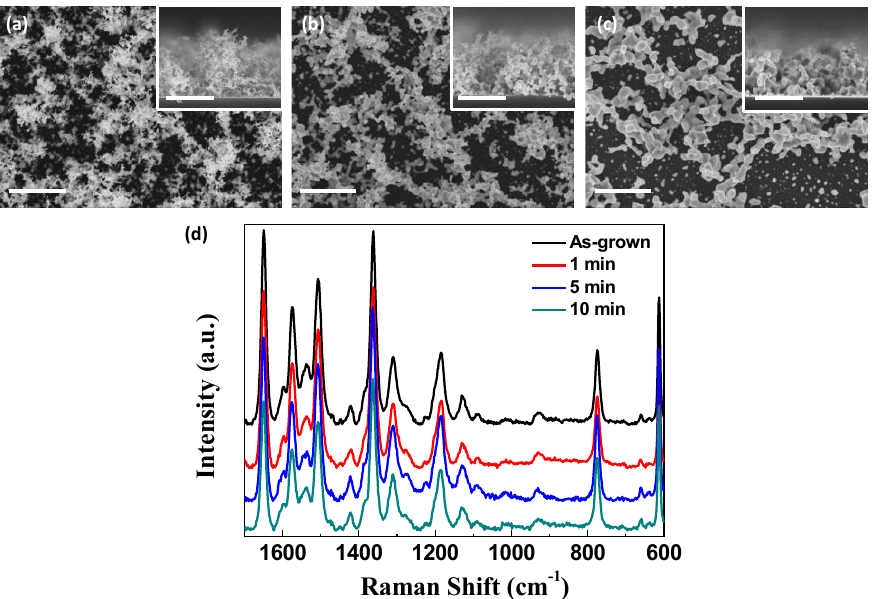
Figure 5. Effect of annealing of the nanoporous Au at 300 °C. Coalescence appears as the nanoporous Au is annealed for ( a ) 1 min, ( b ) 5 min, and ( c ) 10 min All the scale bars are 500 nm. ( d ) Comparison of SERS spectra from the annealed Au nanostructures with the non-annealed one.